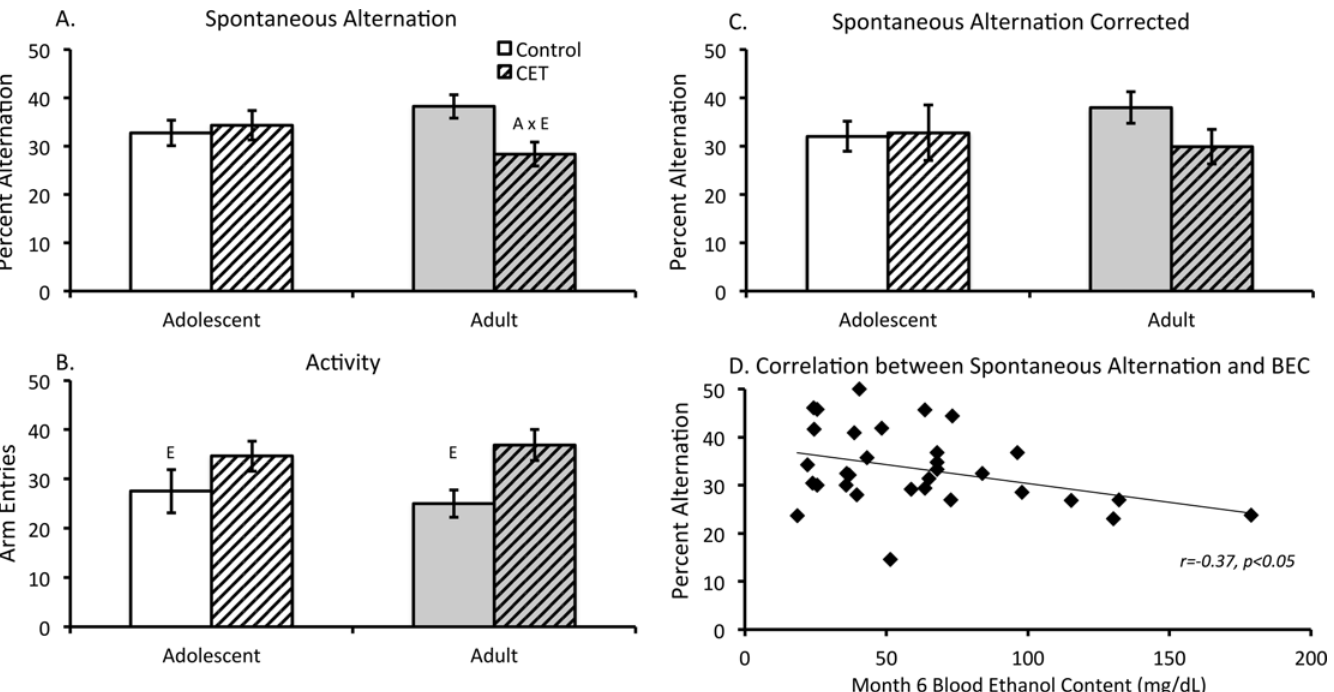
Fig 6. Lower spontaneous alternation behavior correlated with higher blood EtOH concentrations. (A) Percent alternation analysis reveals an Age by Treatment interaction [A x E, p < 0.05], with adult onset CET rats alternating significantly less than age-matched controls. (B) Mean number of arm entries according to Age and Treatment groups. Regardless of age, CET rats made significantly more arm entries compared to controls. (C) Analysis of percent alteration scores corrected for a maximum of 25 arm entries revealed no difference between adult control and CET rats. (D) Final (month 6) BECs were significantly negatively correlated with spontaneous alternation behavior: As BECs increased, spontaneous alternation performance